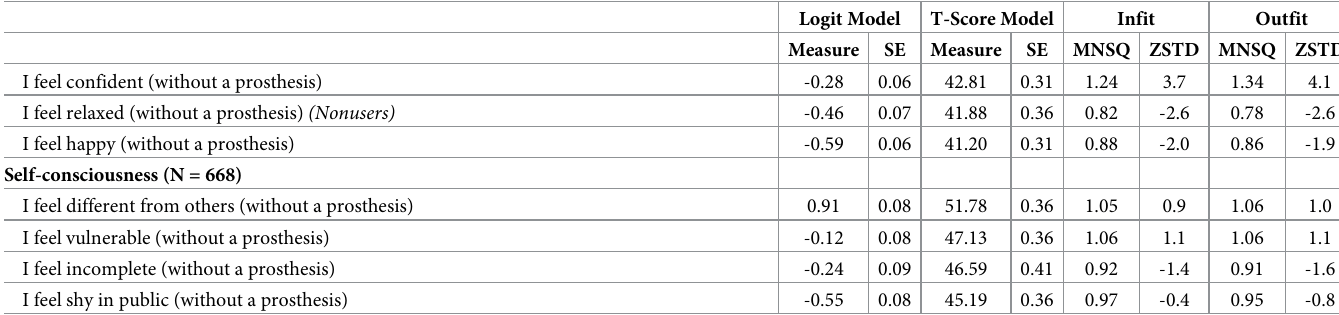
Item-person maps. Rasch item-person maps for each scale (Fig 1) showed that item diffi- culties (including lowest and highest categories) sufficiently covered the range of person ability scores for the social interaction, self-efficacy and embodiment scales. The grey bar in the fig- ures indicates the score range where reliability was > 0.8. There was clustering at the higher levels of ability for the wellbeing and self-consciousness scales, suggesting a need for more dif- ficult items to improve coverage of person ability. Rasch reliability. For each of the scales, person reliability was 0.81 for social interaction, 0.80 for self-efficacy, 0.77 for embodiment, 0.72 for wellbeing, 0.66 for intuitiveness, and 0.65 for self-consciousness. Cronbach’s alpha was 0.90 for social interaction, 0.80 for self-efficacy, and ranged from 0.71 to 0.79 for all other scales (see Table 7). action, self-efficacy, embodiment, intuitiveness, wellbeing, and self-consciousness scales, respectively. Confidence intervals are shown in Table 7. MDC90 and 95% values are also shown in Table 7. Floor and ceiling. For all six PEM scales, less than 15% of the sample were at the floor (1.9%-11.5%) of possible item responses. However, ceiling effects were observed for the self- consciousness (15.8% at ceiling) and wellbeing (16.4% at ceiling) scales.